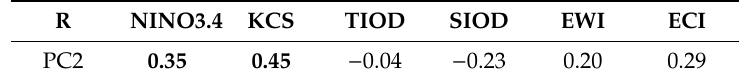
Table 13. Correlation coe ffi cients (R) between PC2 and the SST-indices based predictors (bold font indicates statistically significant values at the 5% level).